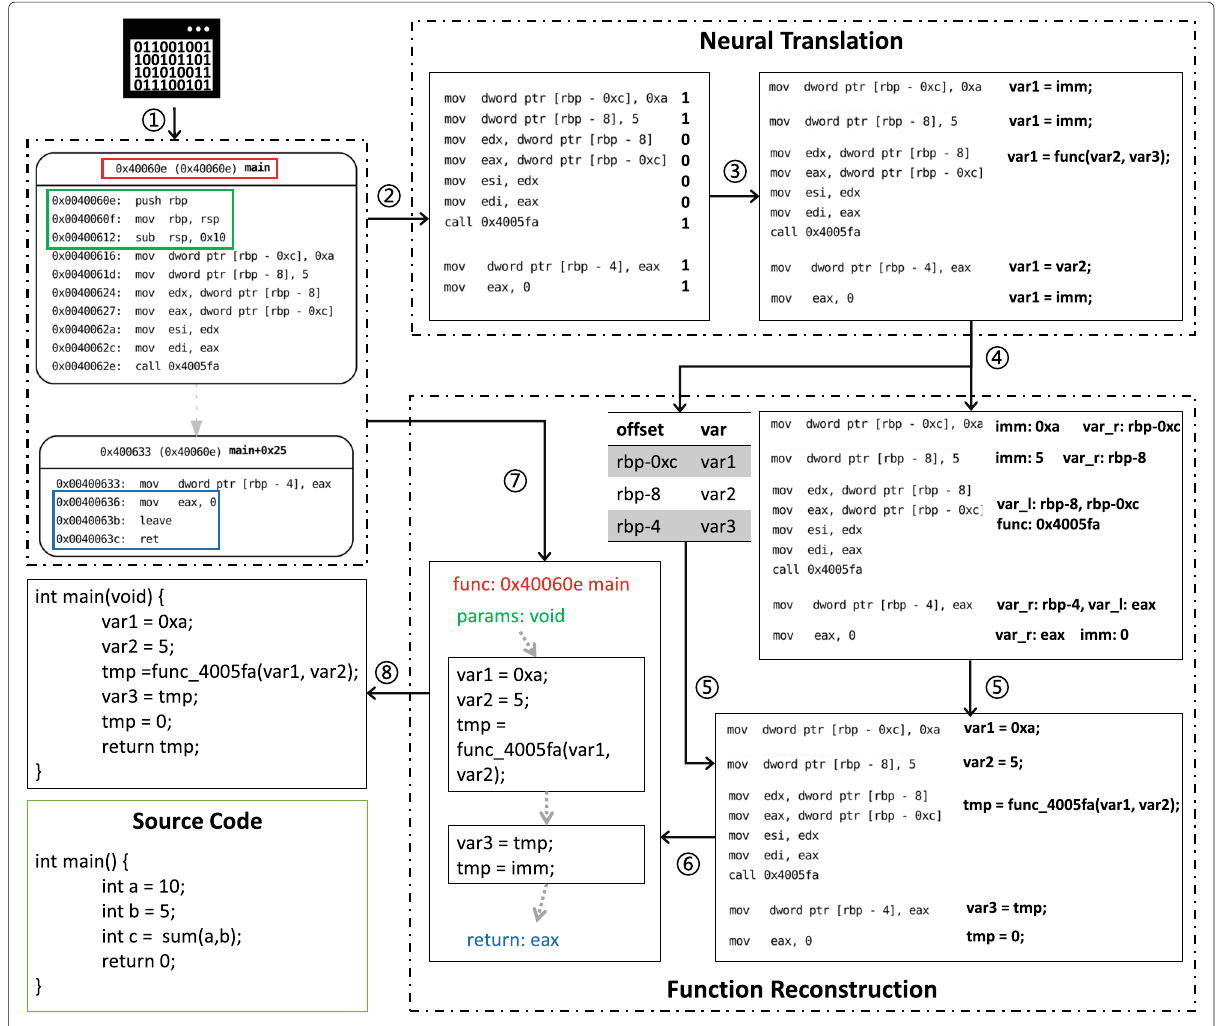
ficulty of NMT model learning decompilation rules. The standardization module focuses on the regular processing of identifiers, numbers, etc. in the PL code, which reduces its impact on model training and translation to learn better the conversion rules between low-level PL and